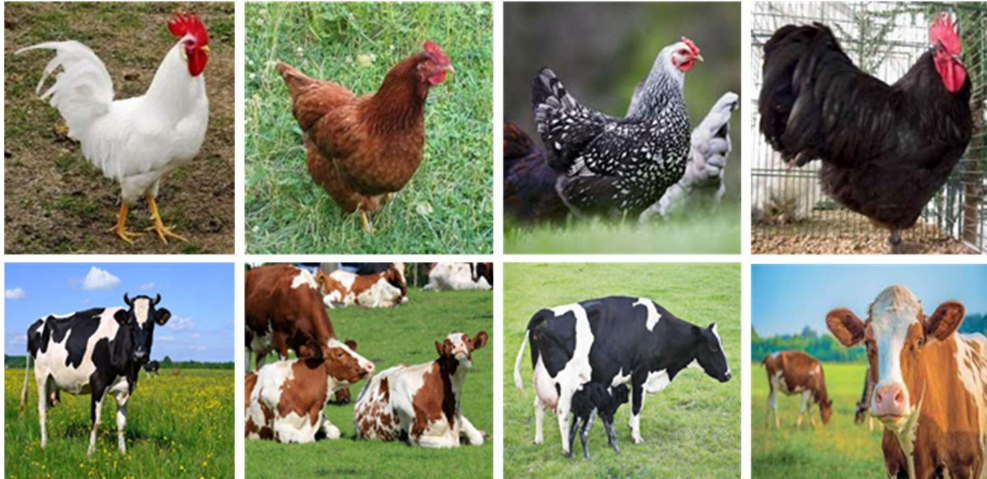
Figure 2. Samples from animal dataset (Dataset B) (first row is chicken class; second row is cow